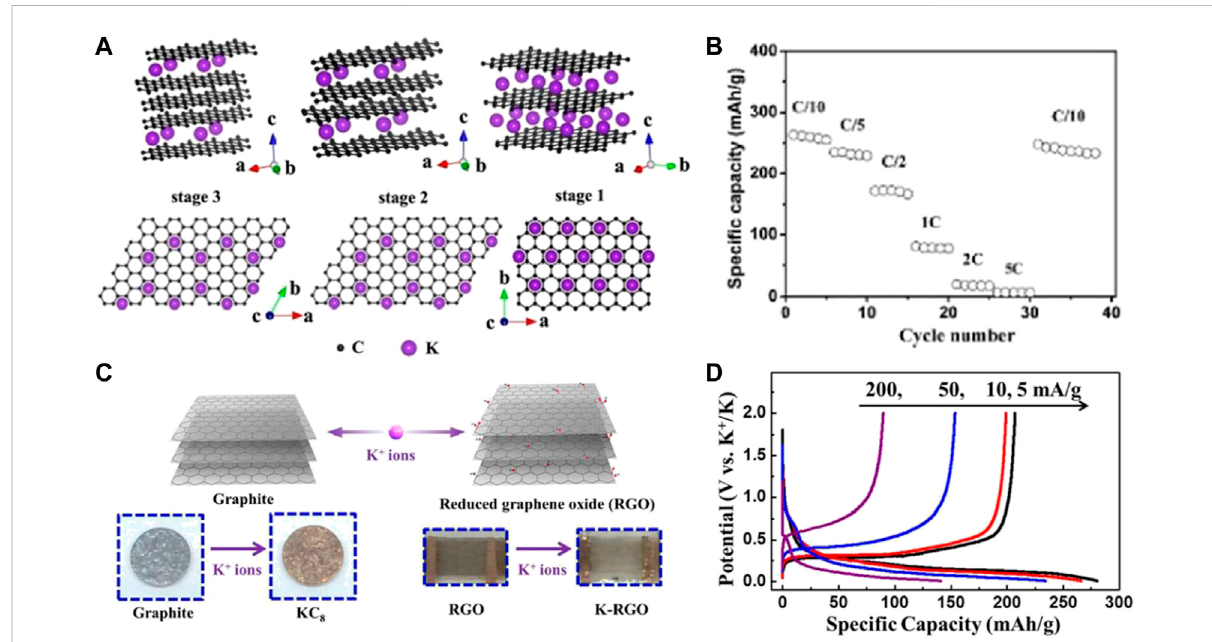
FIGURE 1 (A) Structure diagrams of different K-GICs, side view (up) and top view (down). (B) Rate performance of graphite. Reproduced with permission (Jian et al., 2015). Copyright 2015, ACS. (C) Schematic illustration of electrochemical intercalation of K + into graphite and reduced graphene oxide (RGO). (D) Discharge/charge pro fi les for graphite electrodes at various current densities. Reproduced with permission (Eftekhari et al., 2017). Copyright 2015,